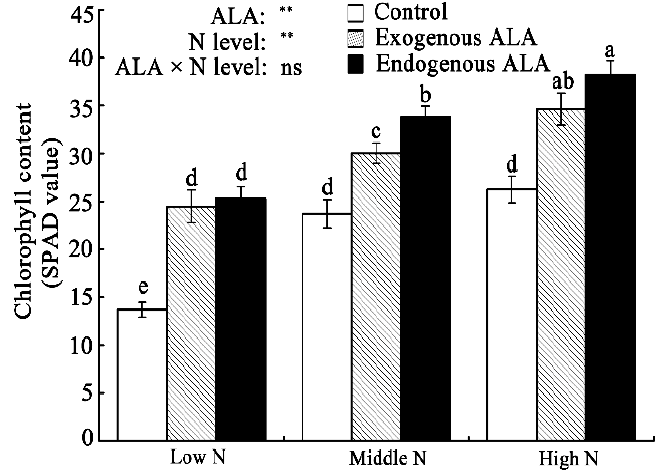
Figure 1. Differences in chlorophyll content (represented as SPAD values) in exogenously 5- aminolevulinic acid (ALA)-treated and endogenous ALA-overproducing canola leaves grown under low-, middle-, and high-N conditions. Means ± standard errors are presented ( n = 10). Means with the same letter indicate a nonsignificant difference ( p > 0.05), according to Duncan’s test. Sources of variation: ALA, N-level, and ALA × N-level interaction; ** p < 0.01; ns: not significant. N = nitrogen.